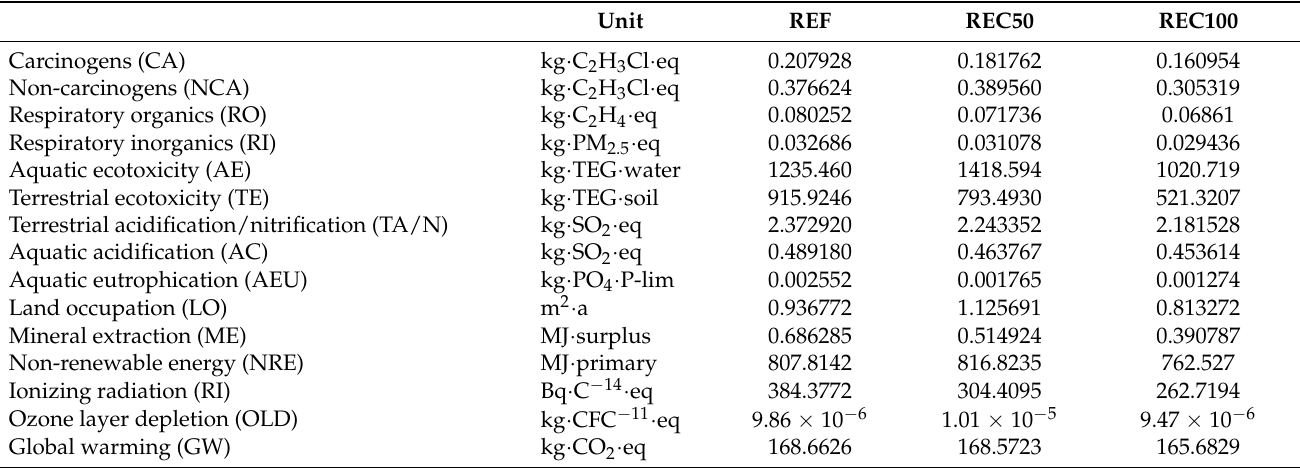
Table 5. Results of assessment of environmental impacts—selected midpoint indicators.